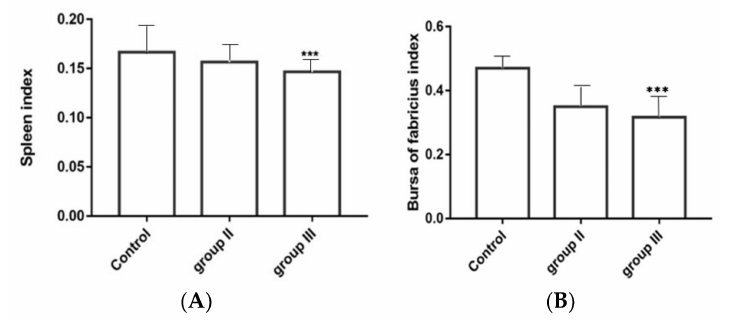
Figure 8. The spleen and bursa were excised and weighed to determine indices of the immune organs, expressed as the weight of immune organs to live body weight. ( A ) spleen index; ( B ) bursa index. *** p < 0.001.